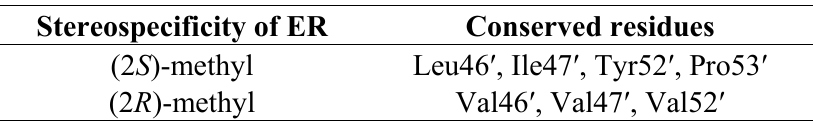
Table 2. ER signature